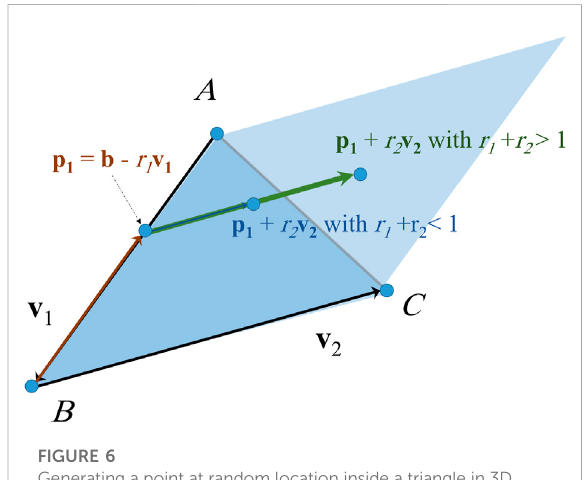
Algorithm2.Generatingapointatarandomlocationwithinatrianglein 3D space.